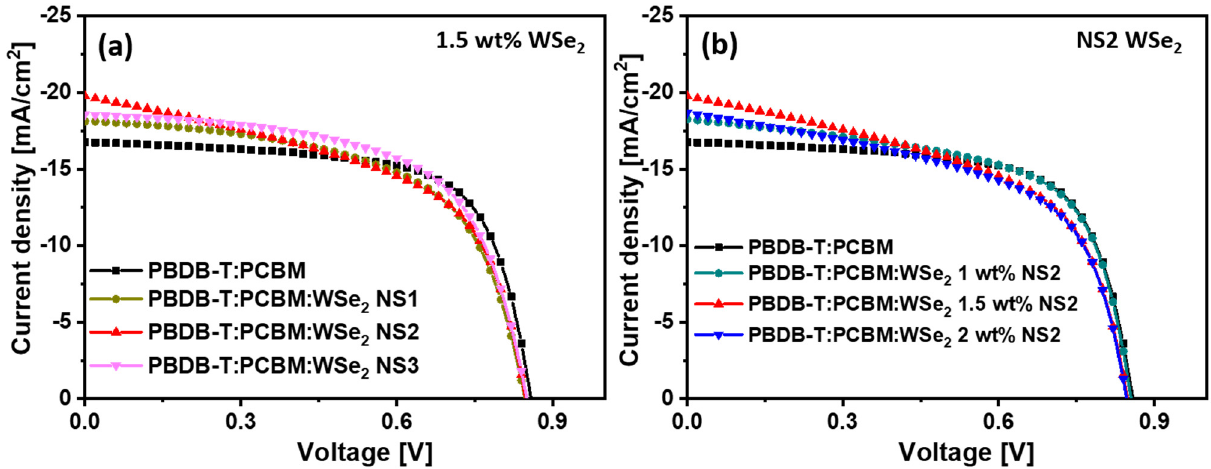
Figure 6. J–V characteristics: ( a ) pristine and different WSe 2 NSs blended PBDB-T:PCBM active layers; ( b ) pristine and different amounts of NS2 WSe 2 NSs blended into the PBDB-T:PCBM active layer. Table 2. PSC performances of pristine and different amounts NS2 WSe 2 NSs blended into the PBDB-T:PCBM active layer using constructed devices (± indicates the standard deviation).